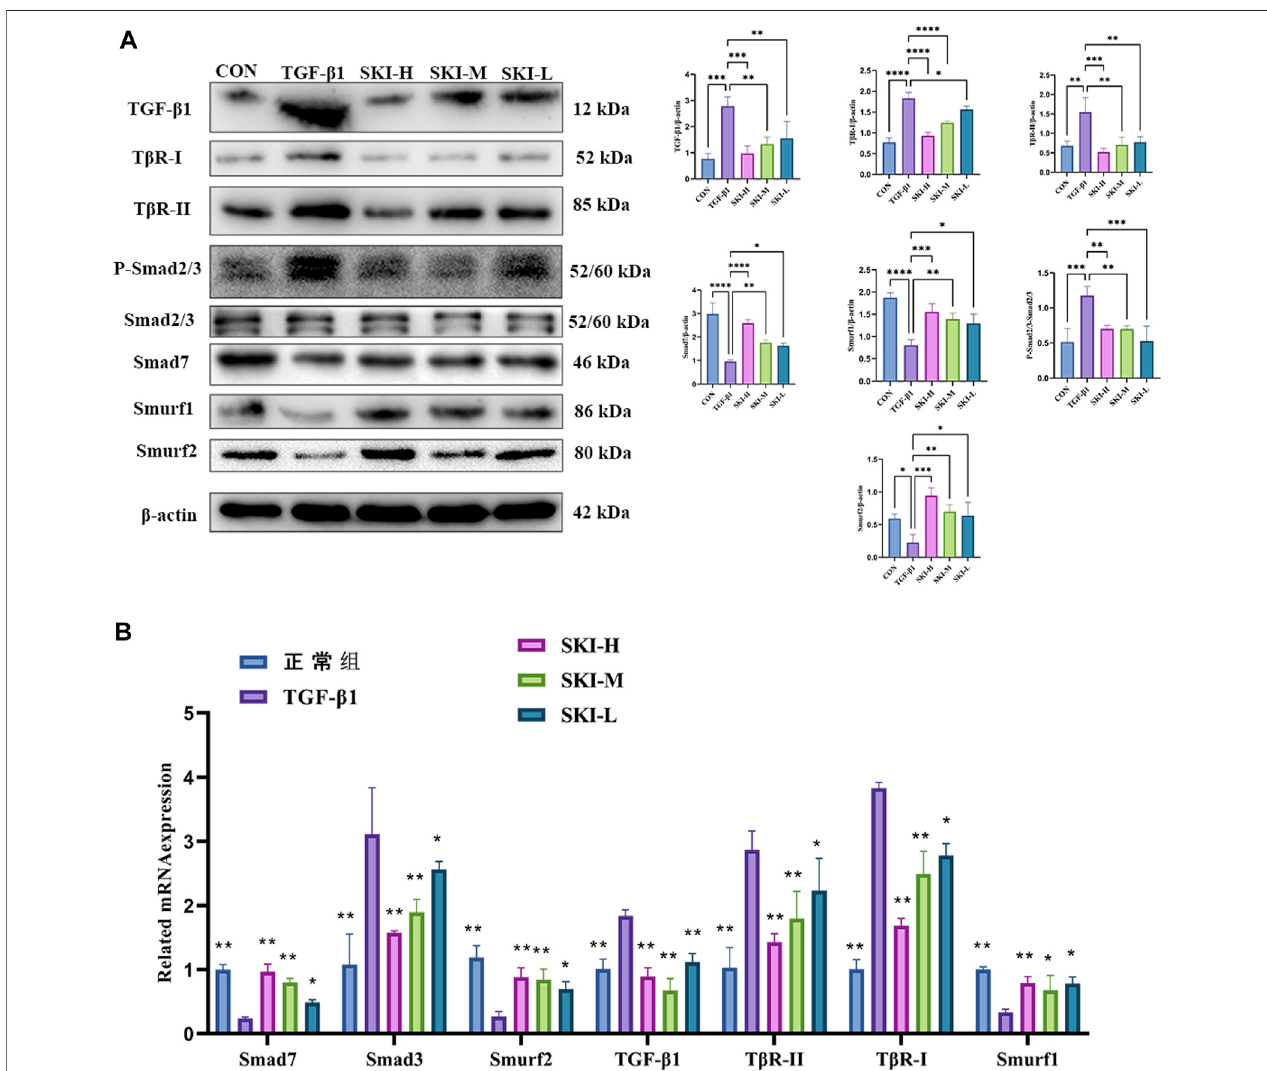
FIGURE 10 | Effects of Shenkang injection on TGF- β /Smads signaling pathway. (A) Western blot was used to detect the expression of TGF- β 1, T β R-I, T β R-II, P-Smad2/3, SmAD2/3, Smurf1, Smurf2, Smad7, and ubiquitin proteins. (B) THE mRNA expressions of TGF- β 1, T β R-I, T β R-II, Smad3, Smurf1, Smurf2, and Smad7 were detected by RT-PCR. Data are shown as mean ± SD. * p < 0.05, ** p < 0.01, *** p < 0.001, and **** p < 0.0001.